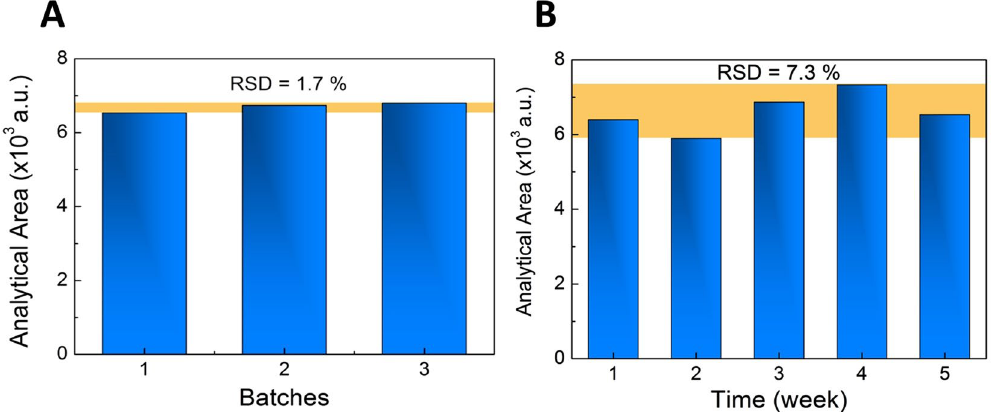
Figure 9. ( A ) Reproducibility of SERS substrate (office paper with AgNSs drop-casted). Area distribution of the 1509 cm − 1 line in the spectra versus the number of batches of AgNSs colloidal solution. ( B ) Stability of SERS substrate (office paper with AgNSs drop-casted). Area distribution of the 1509 cm − 1 line in the spectra versus stored time (5 weeks). Each data point represents the average value from three SERS spectra measured at the vicinity of each spot. The yellow region shows the relative standard deviation (RSD).